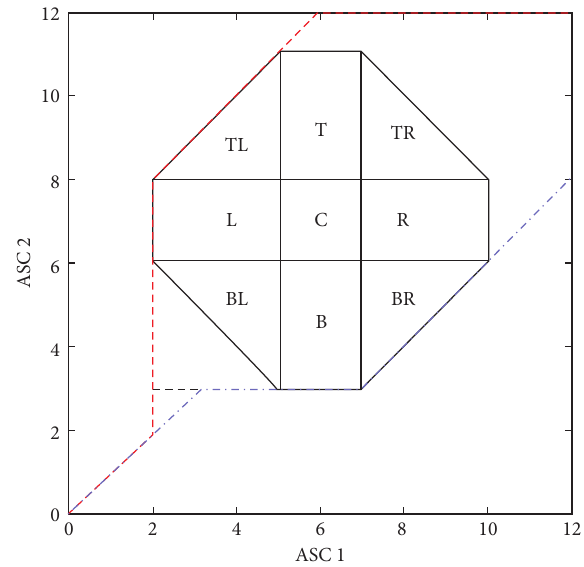
Figure 5: Twin ASCs obstacle